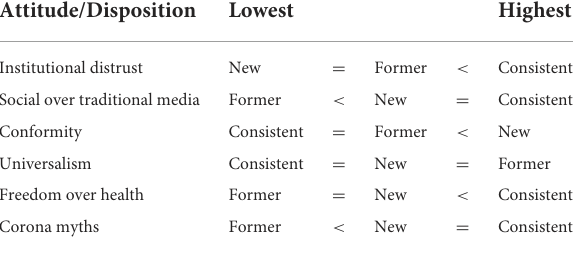
TABLE 5 Differences in attitudes across groups of Corona deniers. TABLE 6 Attitudinal profiles of Corona deniers across East and West